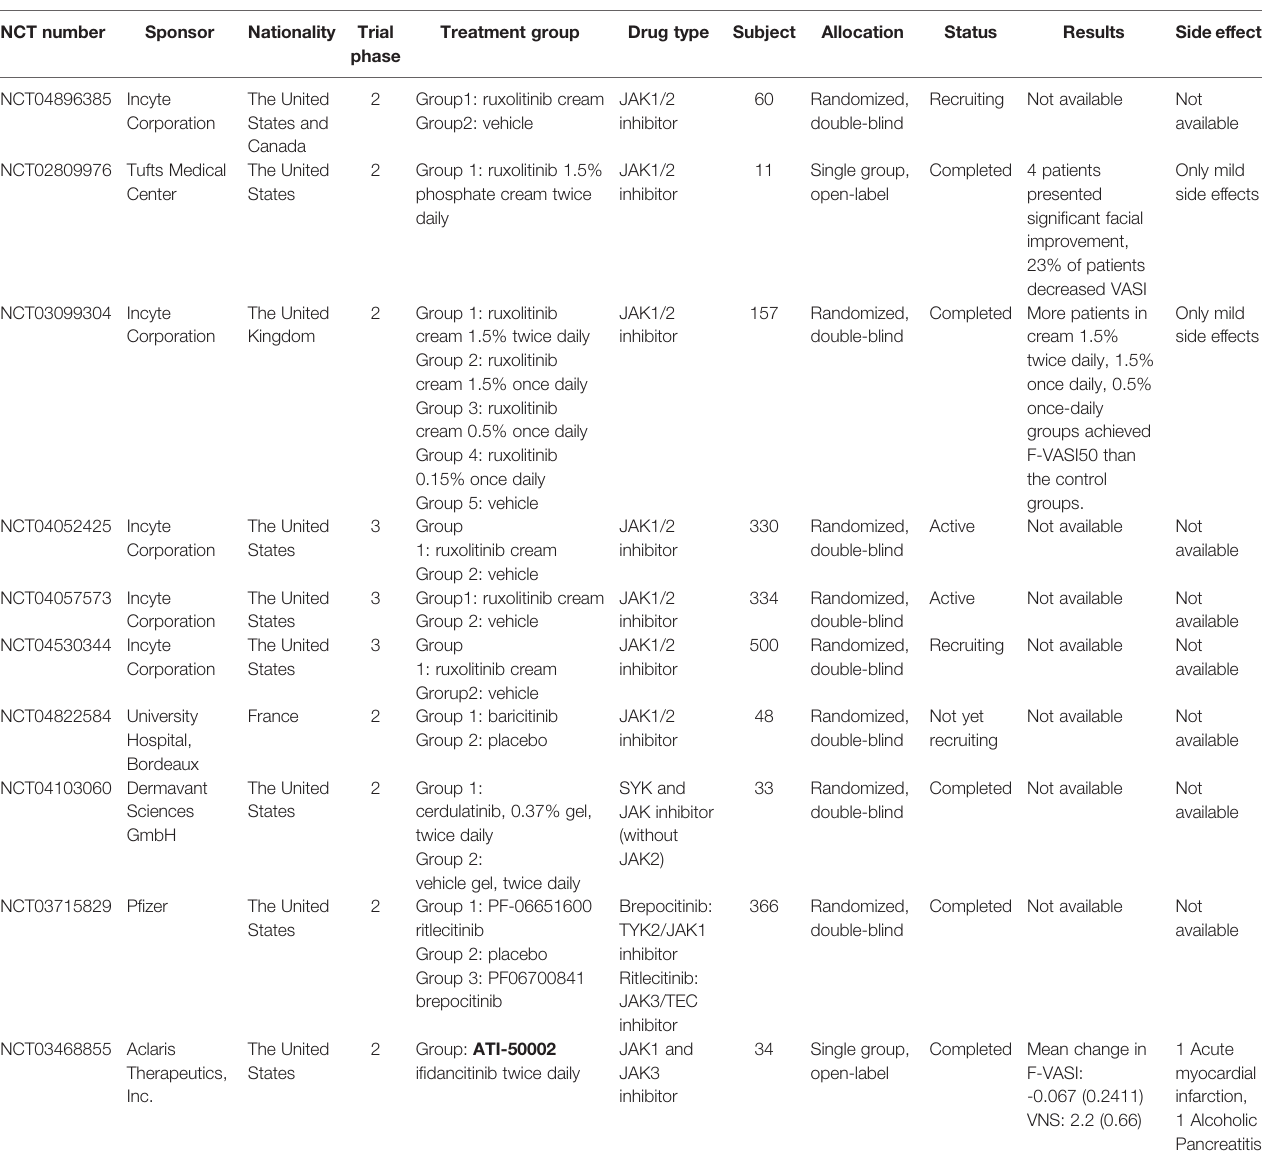
TABLE 1A | Trials of emerging JAK inhibitors in